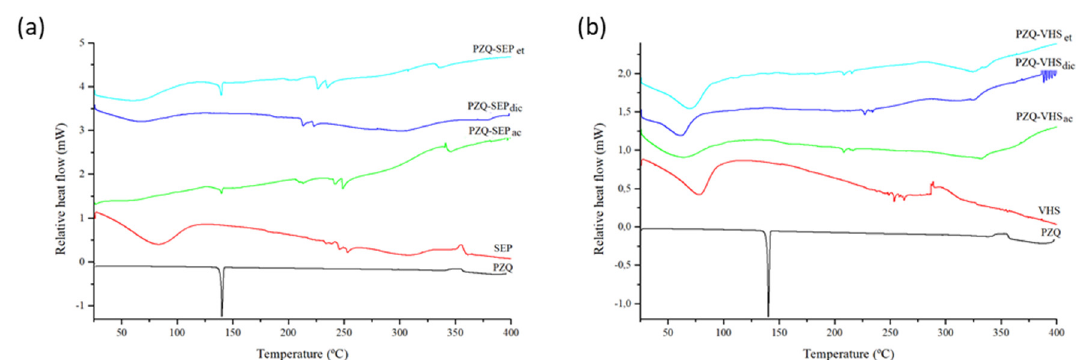
Figure 2. Differential Scanning Calorimetric (DSC) profiles of sepiolite and interaction products of sepiolite ( a ) and montmorillonite and interactions products of montmorillonite ( b ).